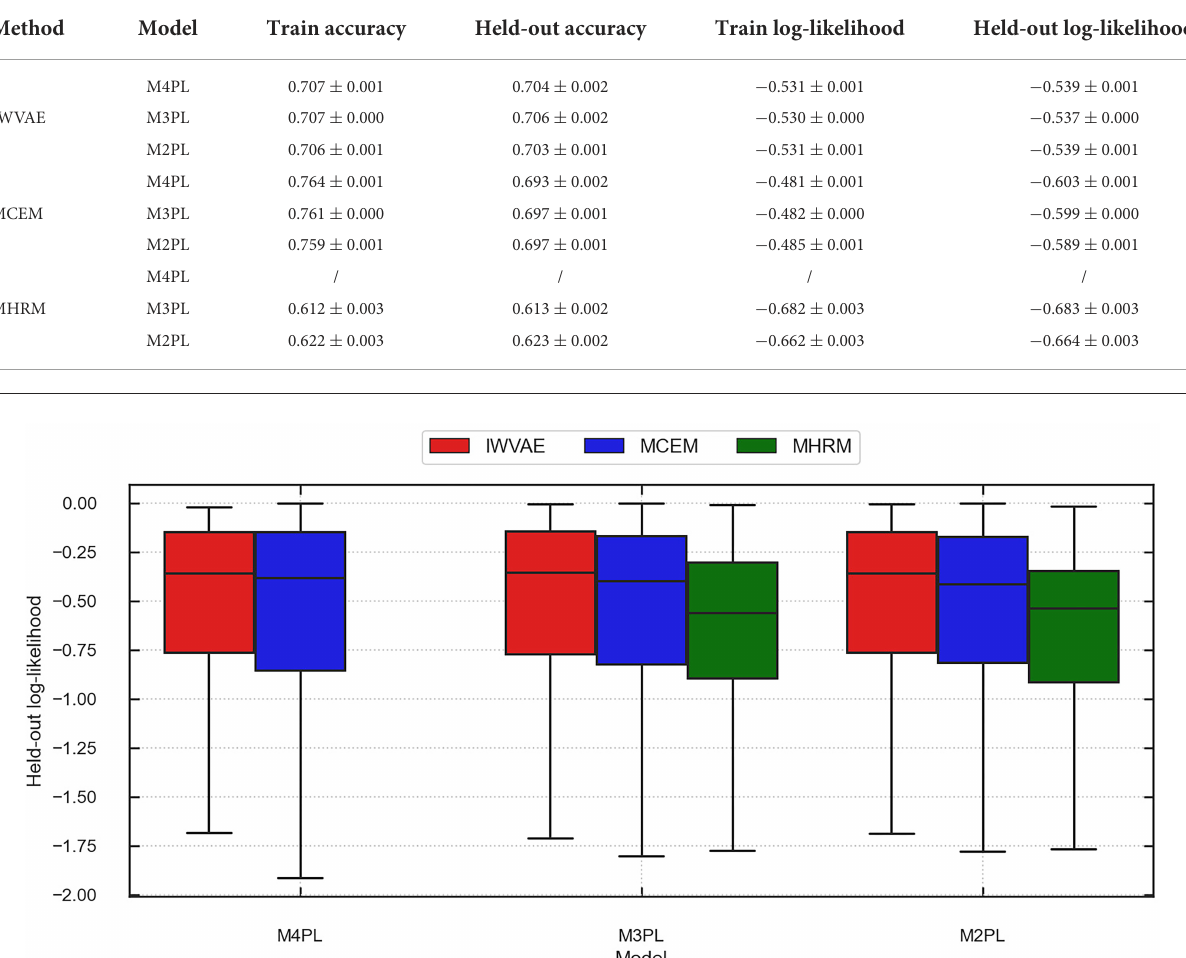
TABLE 10 Mean and SE of train and held-out accuracy/log-likelihood on MST dataset (over 5 replications). Method